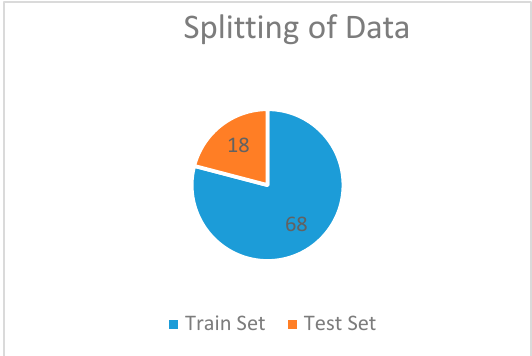
Figure 12. Pie chart for splitting the data set.